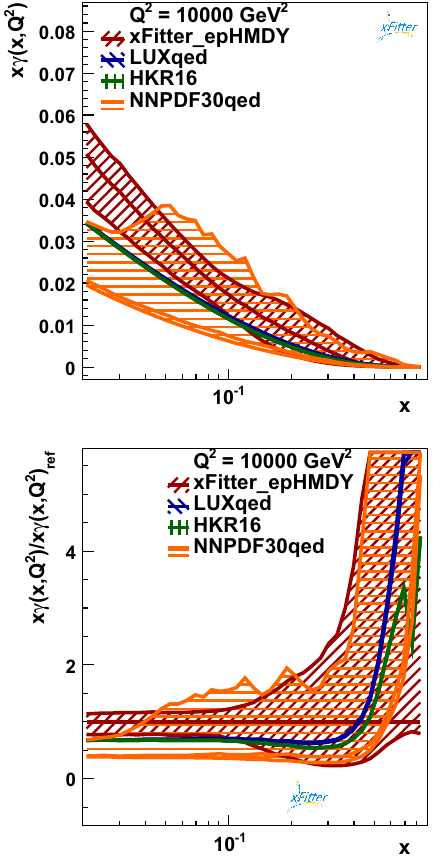
Fig. 4 Same as Fig. 3 for the third and fourth m ll bins